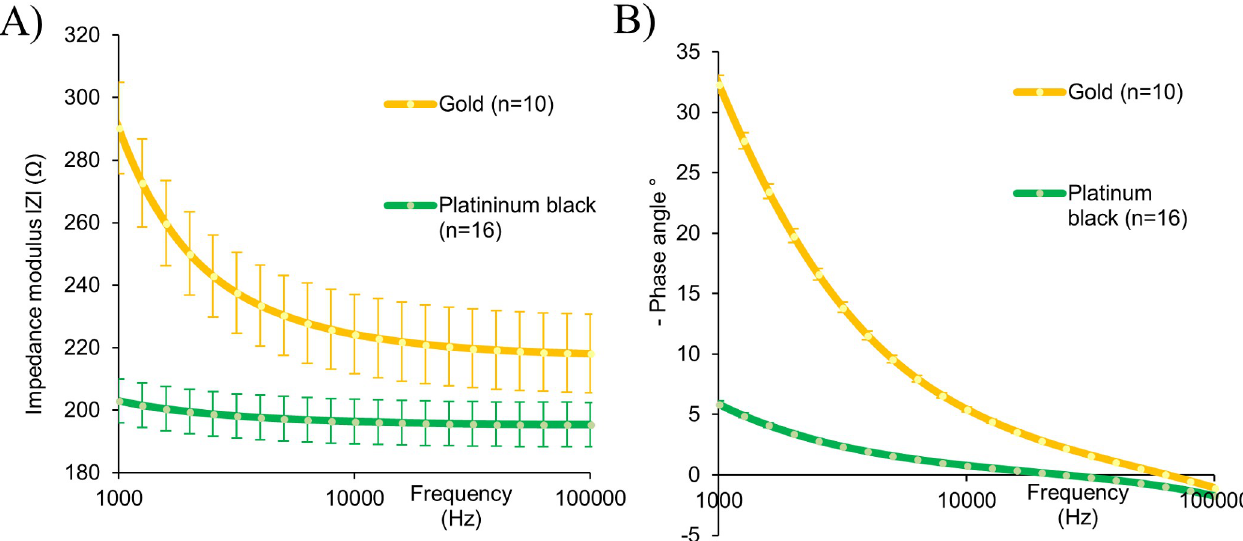
Fig 3. Impedance spectra of gold and platinised electrodes. (A) Impedance modulus and (B) phase angle. Data captured in EC media and represent the mean ± SEM (gold n = 10, platinum n = 16). Error bars are not visible for phase measurements at the scale used, max gold SEM 0.771˚ and max platinum black SEM